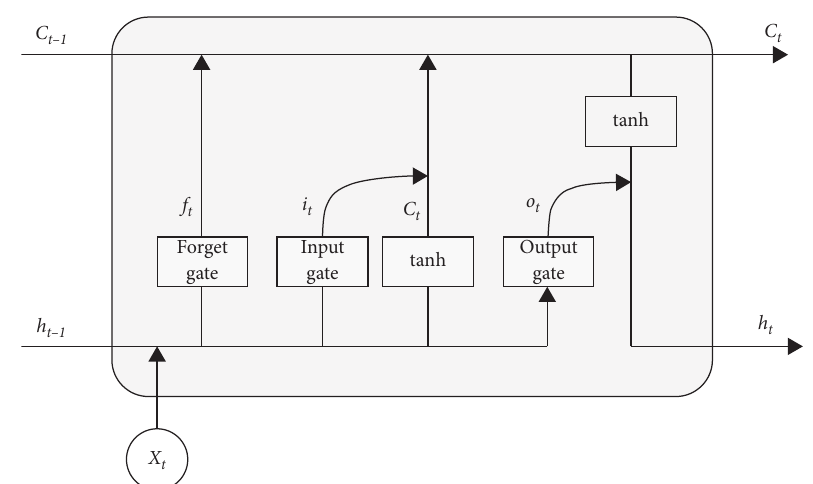
Figure 2: Basic structure of a memory cell with three gates.